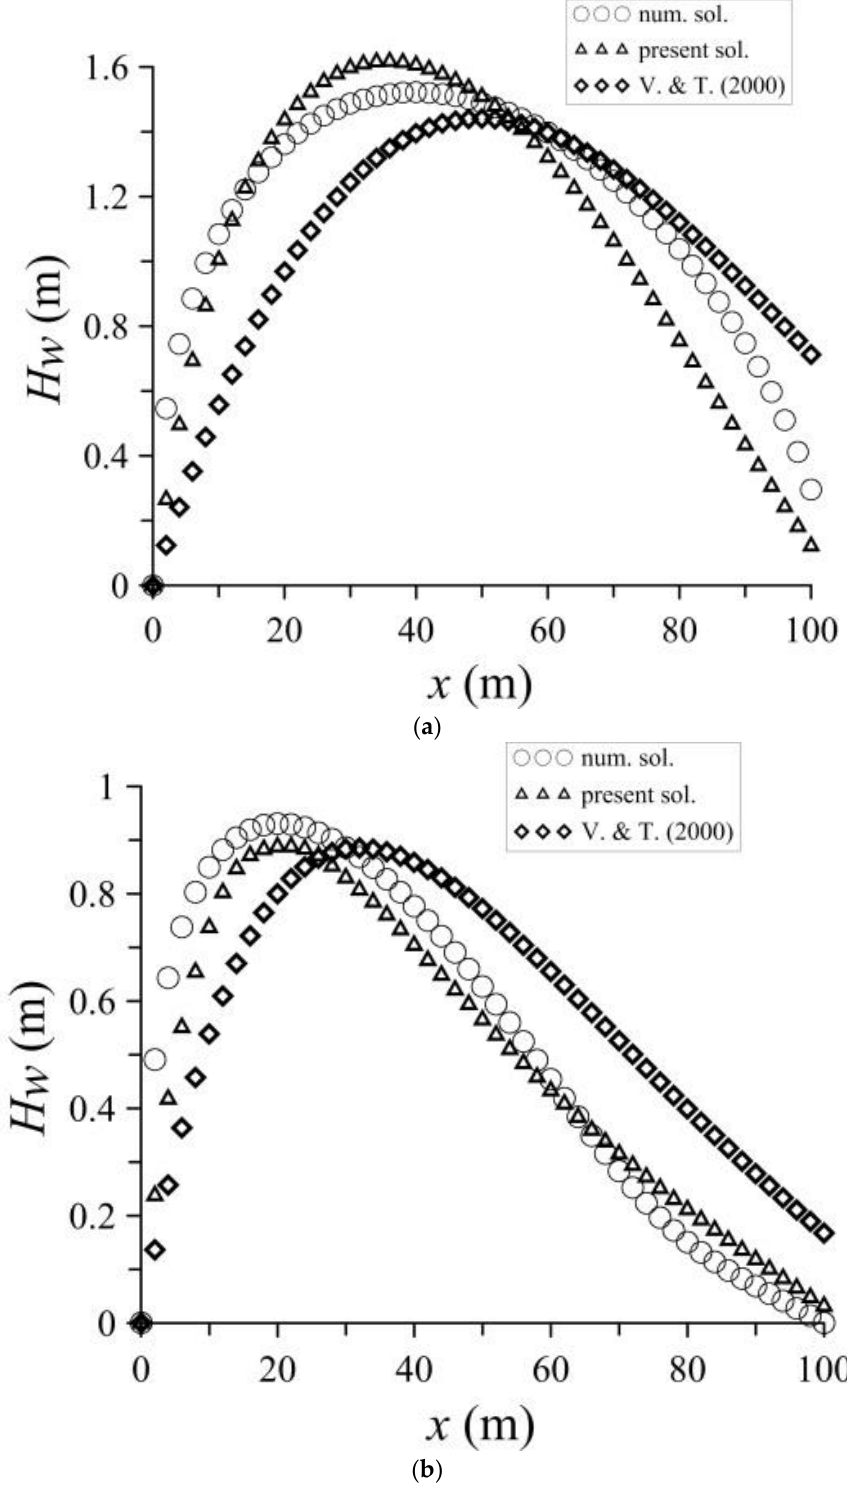
Figure 3. Spatial variation in the groundwater table under constant recharge for ( a ) 𝜃 = 2° ( b ) 𝜃 = 6° ( t = 3 days).